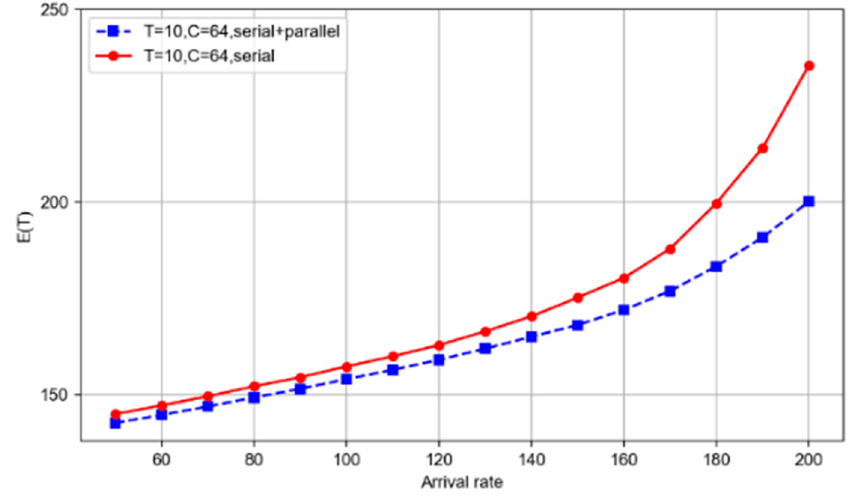
Figure 15. Comparison of algorithm operation strategies.